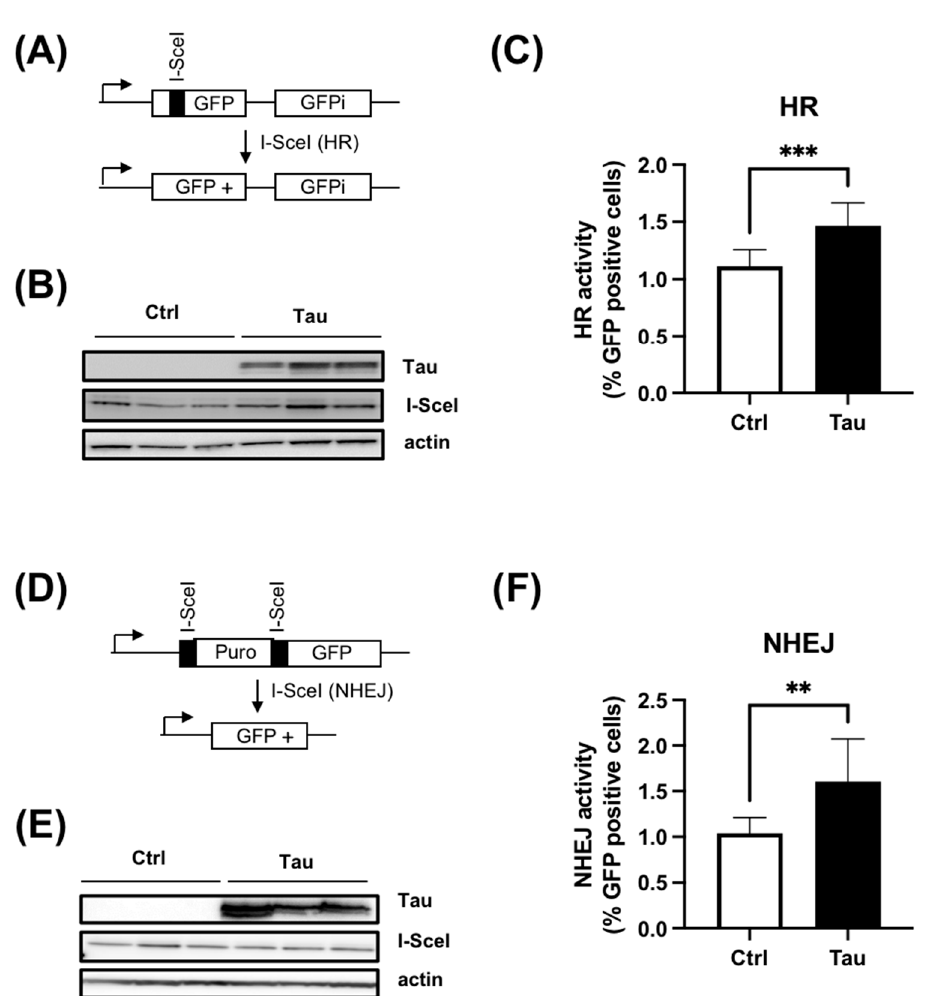
Figure 4. Tau increases HR and cNHEJ activity. ( A ) Schematic representation of DR-GFP reporter. ( B ) Western blot analyses of a HeLa DR-GFP stable clone transiently transfected with plasmid encoding the endonuclease I-SceI with or without plasmid encoding Tau protein. ( C ) Tau increases HR activity. HeLa DR-GFP cells were transfected as described in ( B ). The percentage of GFP-positive cells was quantitated by flow cytometry (five independent experiments). Results are expressed as fold induction relative to the control. ( D ) Schematic representation of EJ5GFP reporter. ( E ) Western blot analyses of HeLa EJ5-GFP stable clone transiently transfected with plasmid encoding the endonuclease I-SceI with or without plasmid encoding Tau protein. ( F ) Tau increased cNHEJ activity. HeLa EJ5-GFP cells were transfected as described in ( E ). The percentage of GFP-positive cells was quantitated by flow cytometry (Five independent experiments). Results are expressed as fold induction relative to the control. Data are mean ± SD ** p < 0.01; *** p <